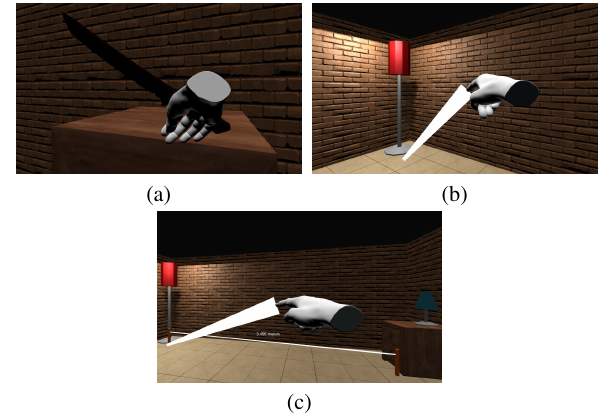
Figure 3. Gestures associated to the actions of (a) pinch, (b) point and (c) measure. Pinch allows users to pick up objects. Point allows users to highlight objects. Measure allows users to measure distances between virtual